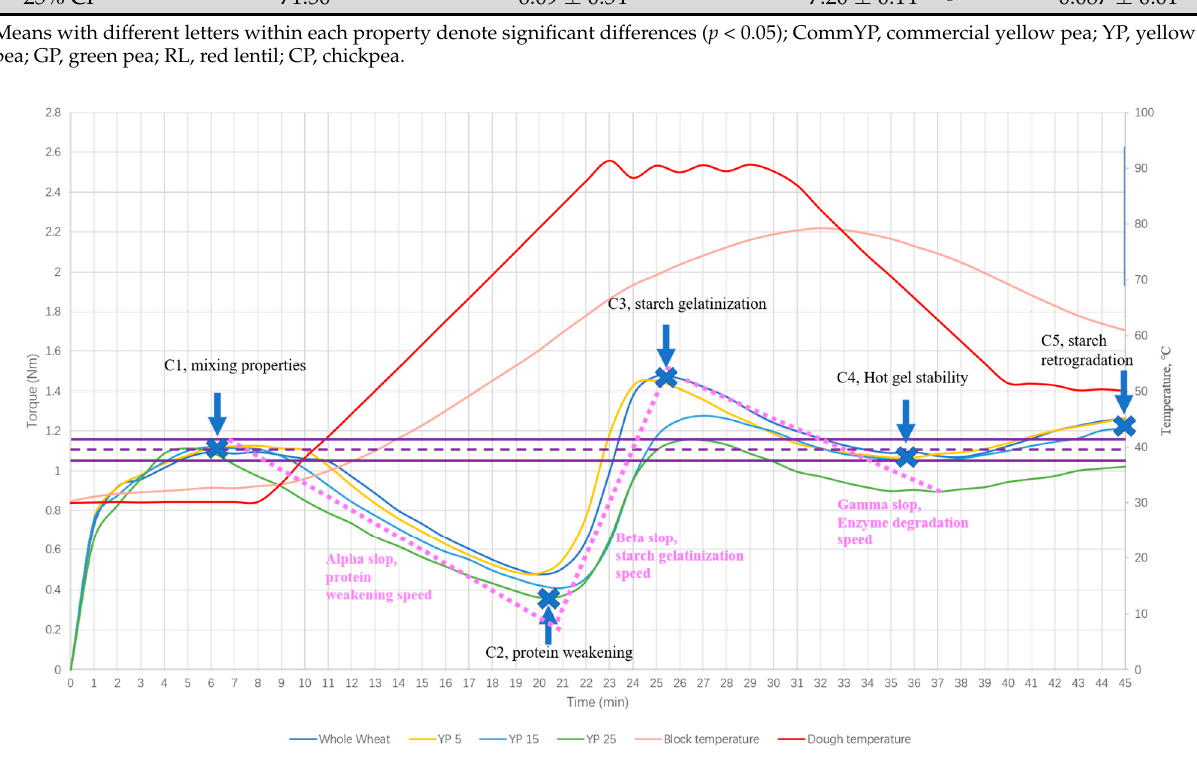
Figure 2. Example Mixolab graph (whole wheat, 5, 15, and 25% yellow pea flour). * YP, yellow pea flour.